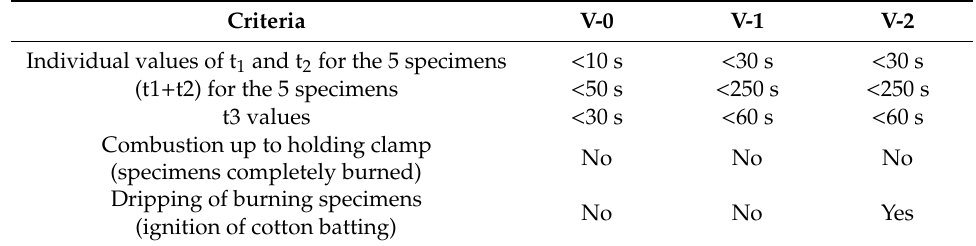
Table 2. Criteria for Underwriters Laboratory UL-94 classification